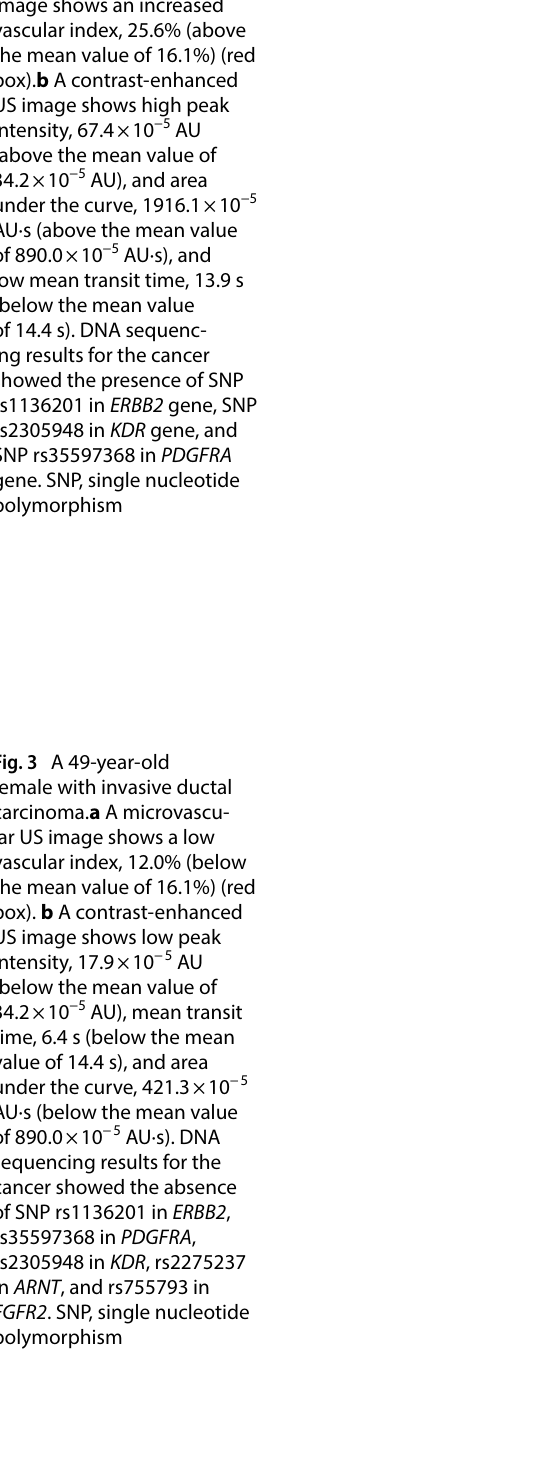
Fig. 3 A 49-year-old female with invasive ductal carcinoma. a A microvascu- lar US image shows a low vascular index, 12.0% (below the mean value of 16.1%) (red box). b A contrast-enhanced US image shows low peak intensity, 17.9 × 10 − 5 AU (below the mean value of 34.2 × 10 −5 AU), mean transit time, 6.4 s (below the mean value of 14.4 s), and area under the curve, 421.3 × 10 − 5 AU·s (below the mean value of 890.0 × 10 − 5 AU·s). DNA sequencing results for the cancer showed the absence of SNP rs1136201 in ERBB2 , rs35597368 in PDGFRA , rs2305948 in KDR , rs2275237 in ARNT , and rs755793 in FGFR2 . SNP, single nucleotide